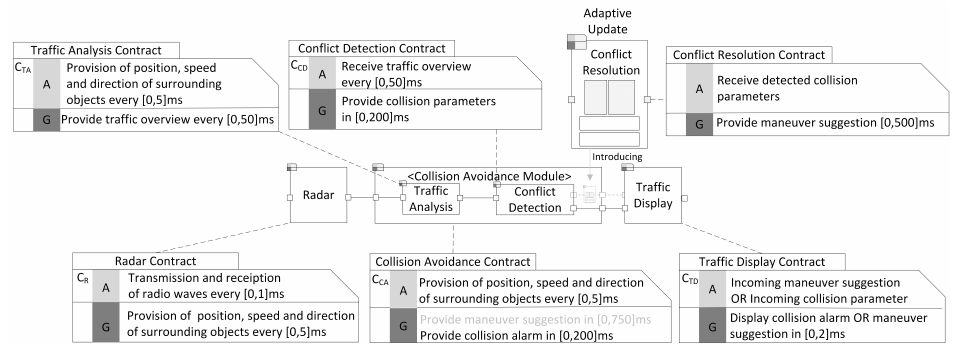
Figure 11. A collision avoidance system updated with a conflict resolution module as new